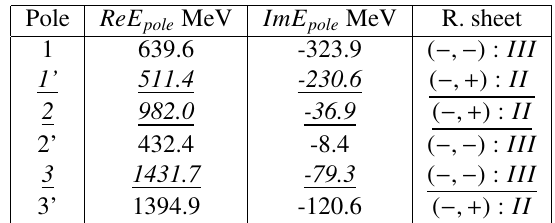
Table 1. Positions of two channel S -matrix poles found in analysis of scalar-isoscalalr ππ interactions